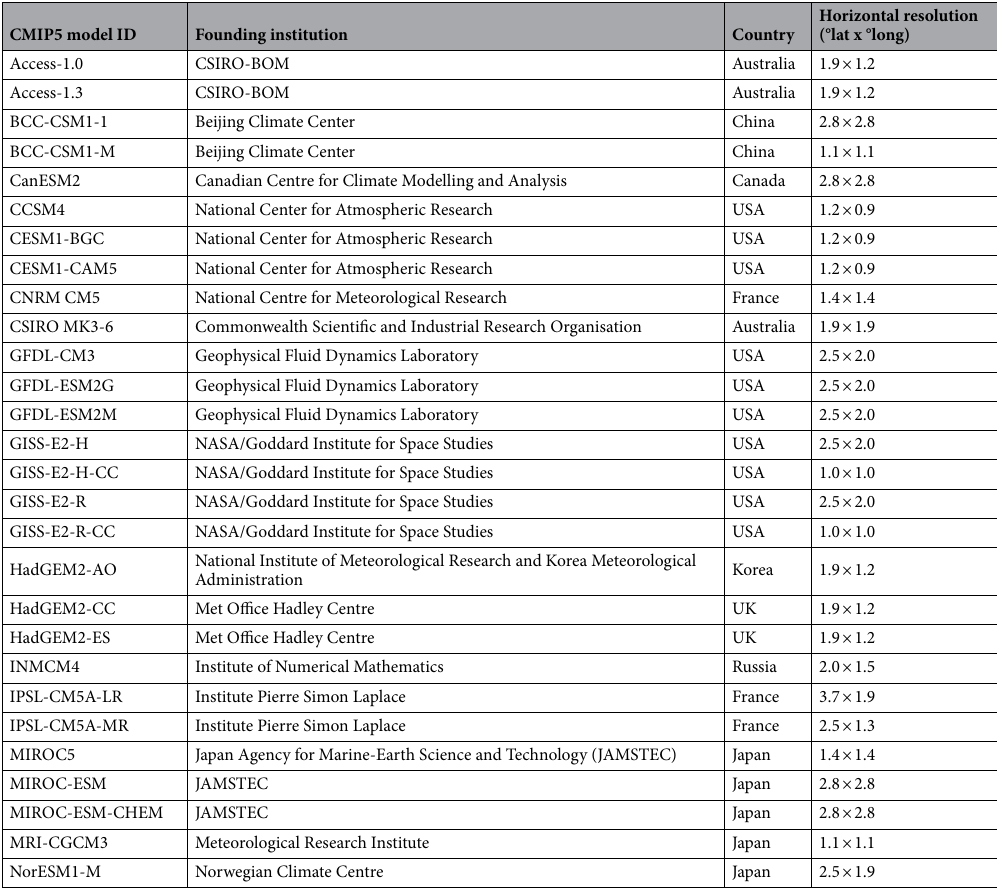
Table 2. List of global climate models (GCMs), their founding institution and spatial resolution.